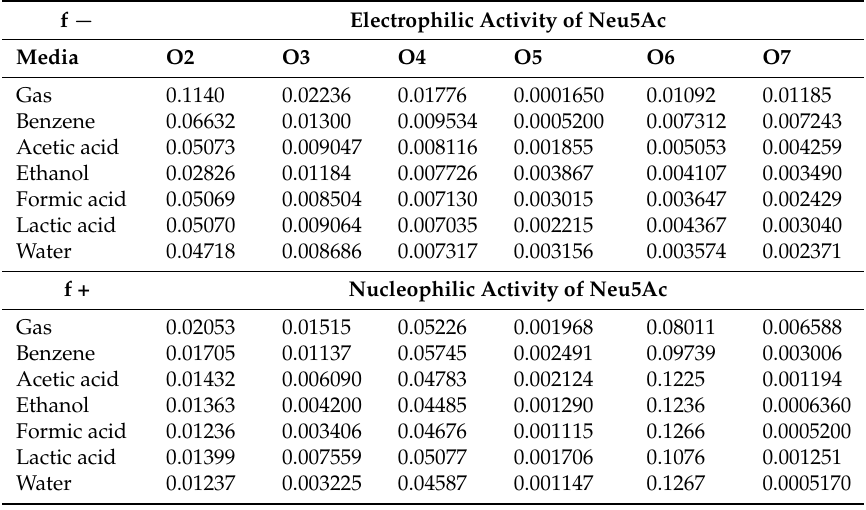
Table 4. Condensed Fukui function of Neu5Ac at the M062X/6-311G(d,p) level, keep four